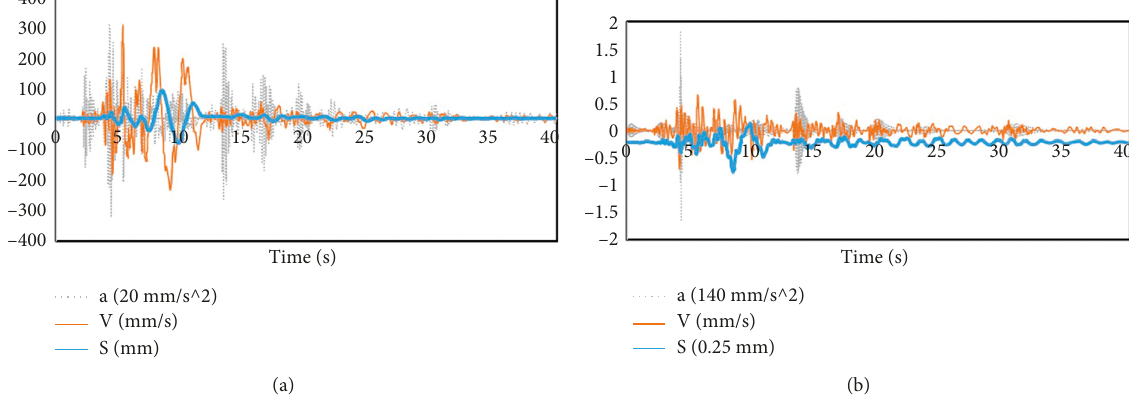
Figure 54: Time course curves of bearing deformation displacement, velocity and acceleration when N90 is input from Y direction. (a) Horizontal deformation. (b) Vertical deformation.